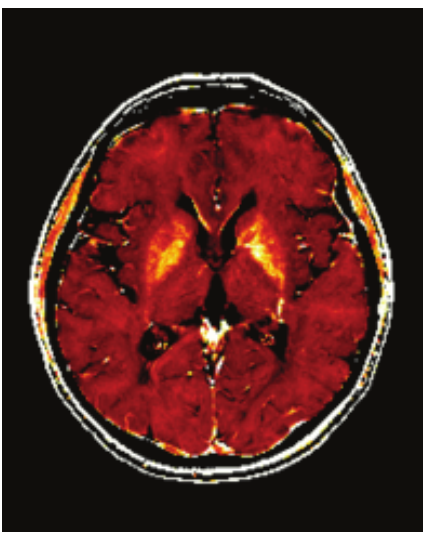
Figure 1: R2 ∗ map of a 50-year-old female MS patient. Higher iron concentrations in basal ganglia structures are reflected by brighter signal